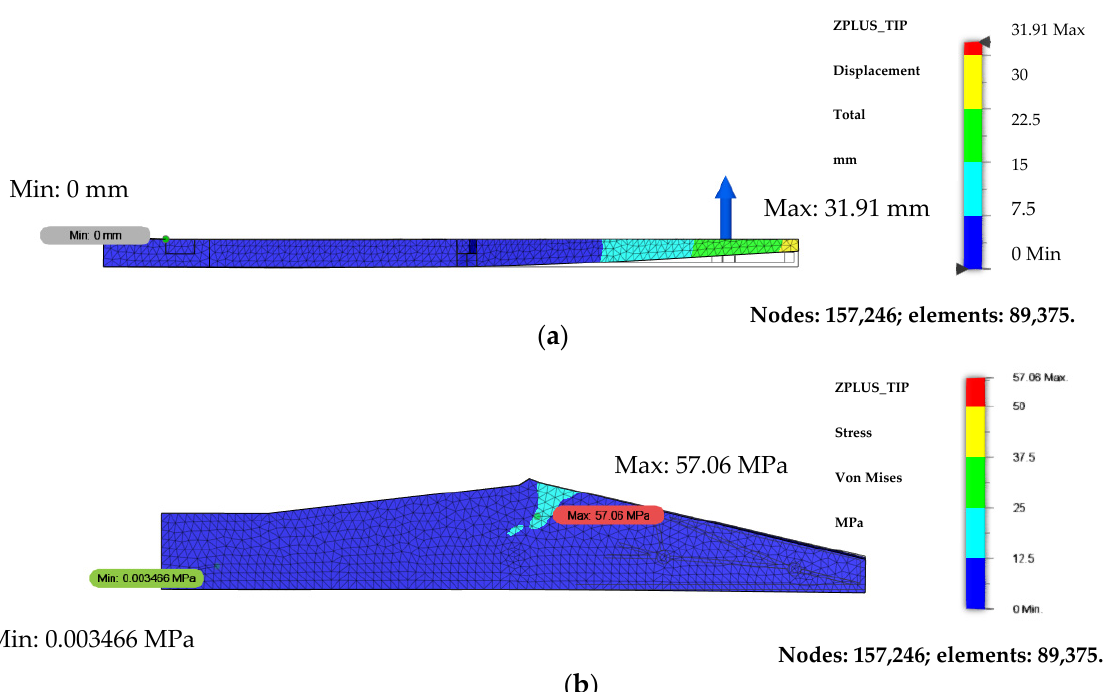
Figure 7. Displacement plot viewed from the top ( a ) and von Mises stress plot viewed from the front ( b ).